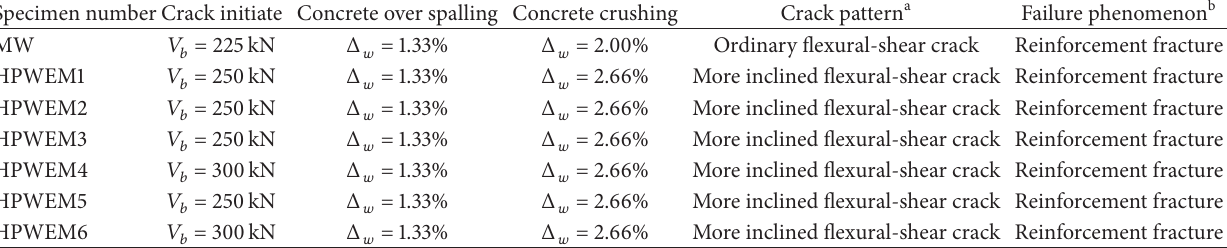
Table 3: Test observations of the